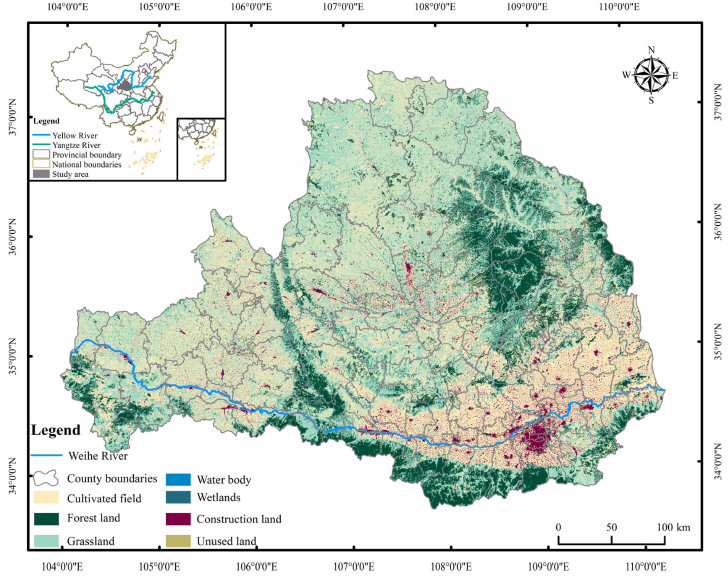
Figure 1. Geographic map of the Weihe River Basin of